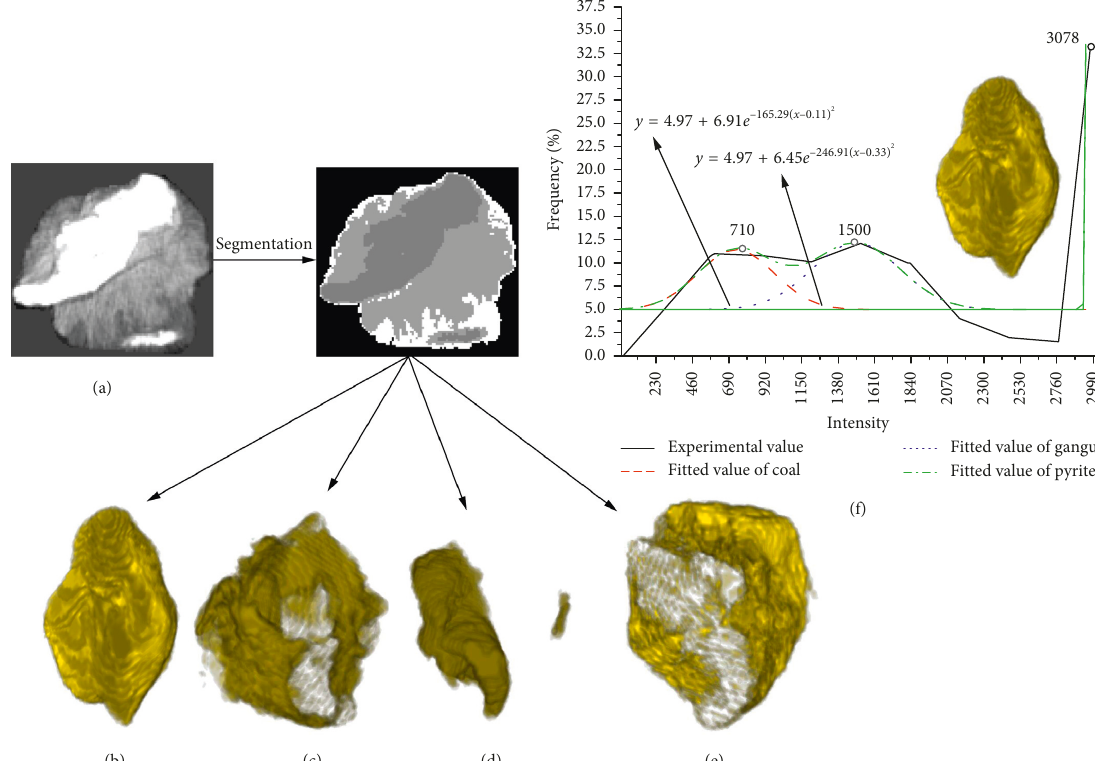
Figure 9: Intensity-frequency distribution curves and 3D volume-rendering image for the selected triphase particle. This figure presents (a) the original CT image; (b) the whole particle; (c) the gangue phase; (d) the pyrite phase; (e) the coal phase; (f) the frequency distribution curve of